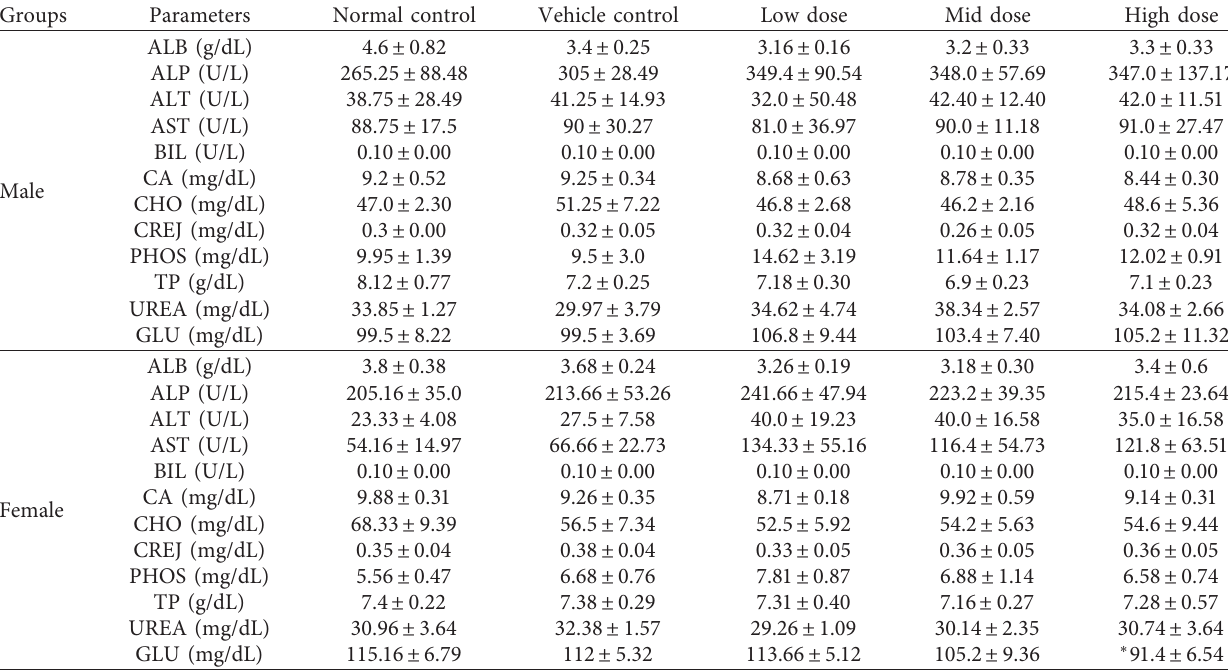
Table 4: Evaluation of biochemical parameters in the repeated dose inhalation subacute toxicity study of AND-2-HyP- β -CYD complex. Groups